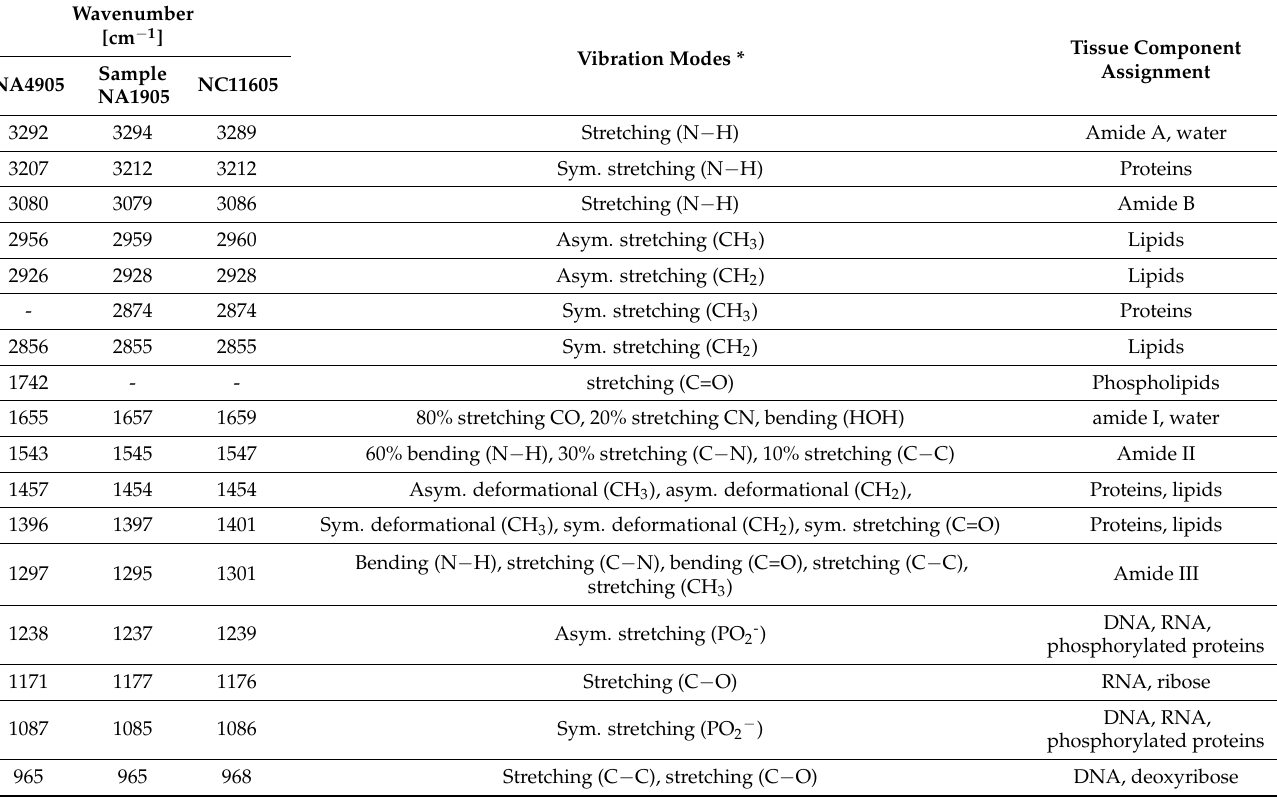
Table 1. The most important bands obtained in the FT-IR spectra of tissue samples affected by Aeromonas